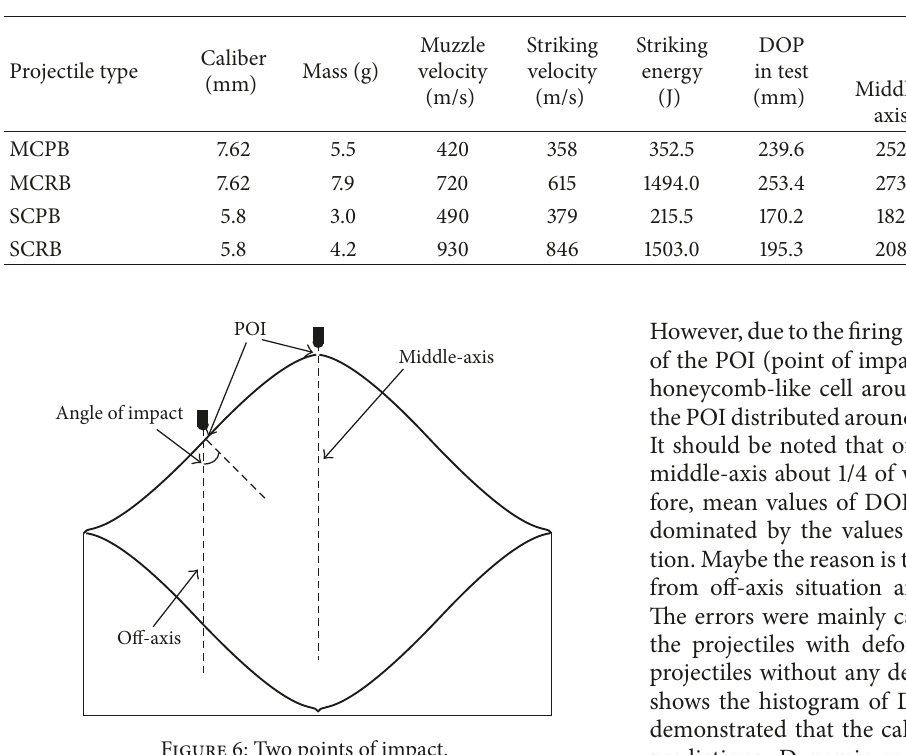
Figure 5: Sketch of simulation model. Table 2: Properties of projectiles and the DOP data obtained from experiment and numerical simulations.